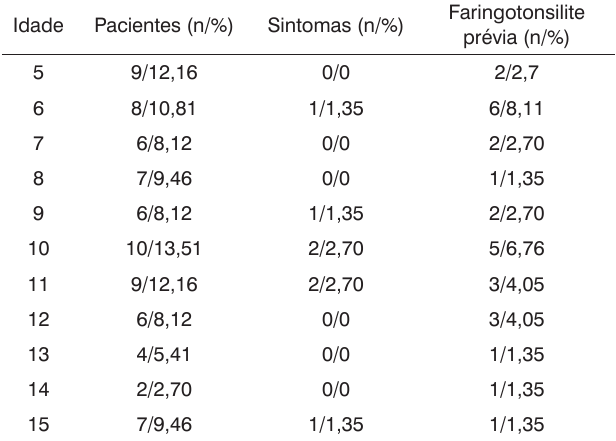
Tabela 1. Características de indivíduos sintomáticos com necessidades especiais e faringotonsilites prévias reportadas.